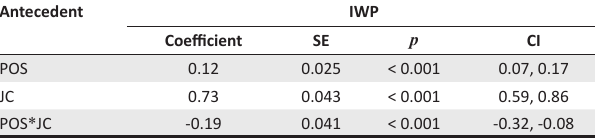
TABLE 3: Moderating role of job crafting.